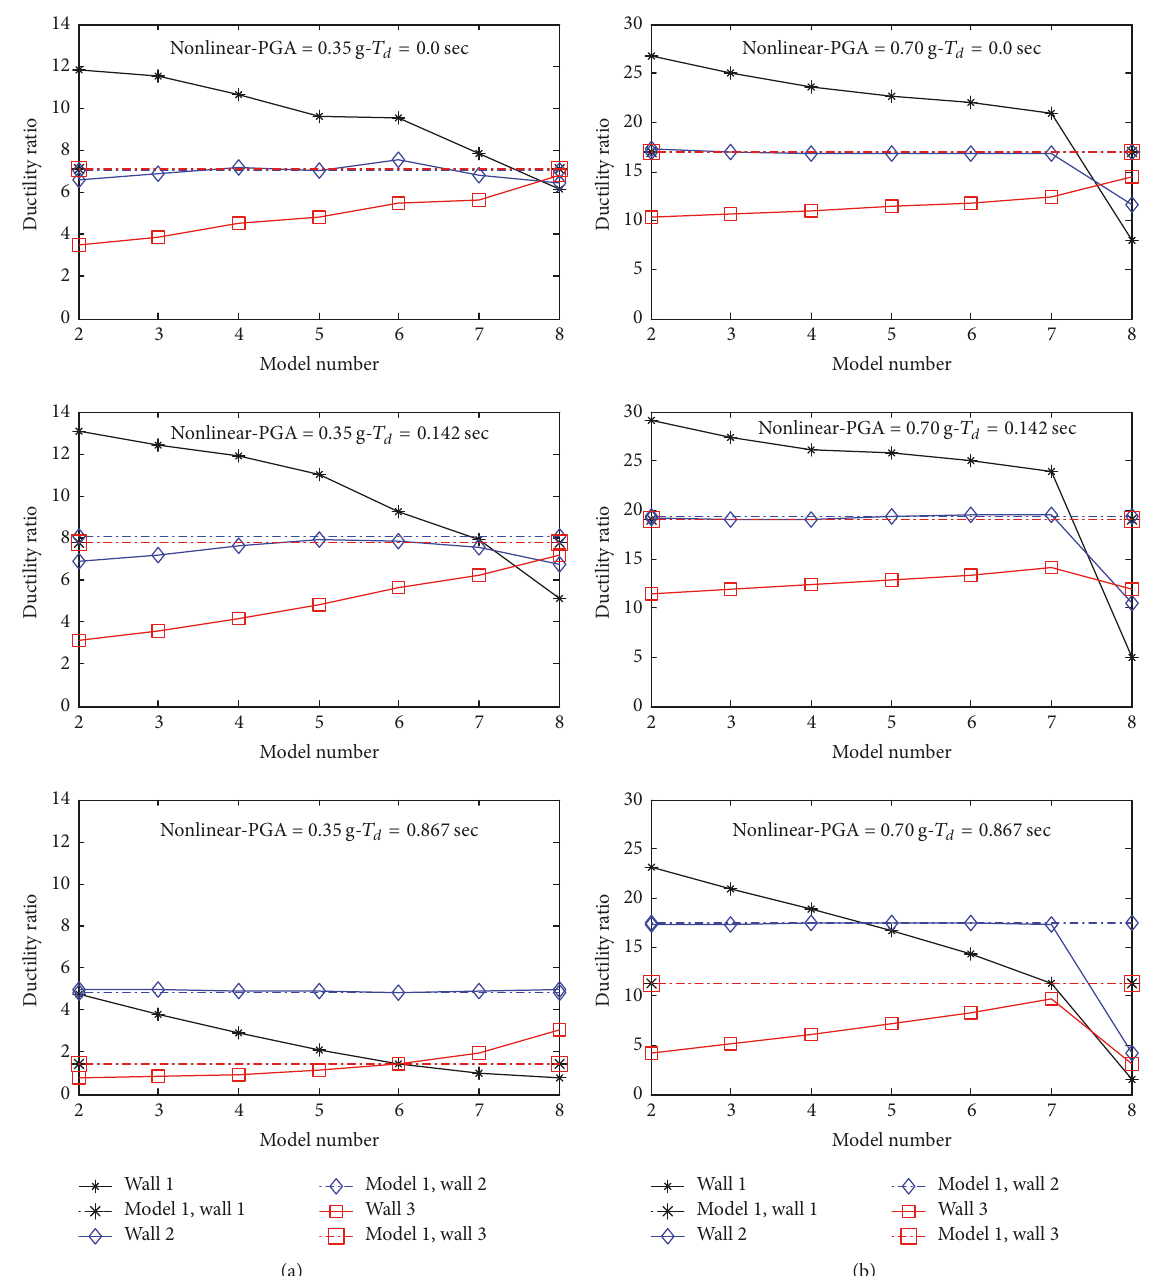
Figure 17: The mean of maximum ductility demands of walls in asymmetric structures: (a) DBE earthquake (0.35 g) and (b) MCE earthquake (0.70